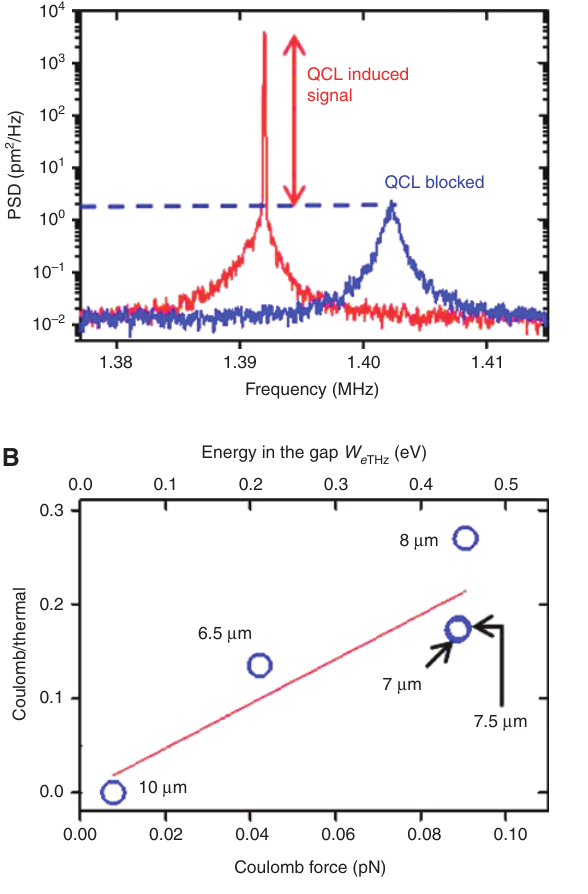
force F , for structures identified by the value of the length L Coul Figure 1C and D). The top x -axis reports the values of the electric